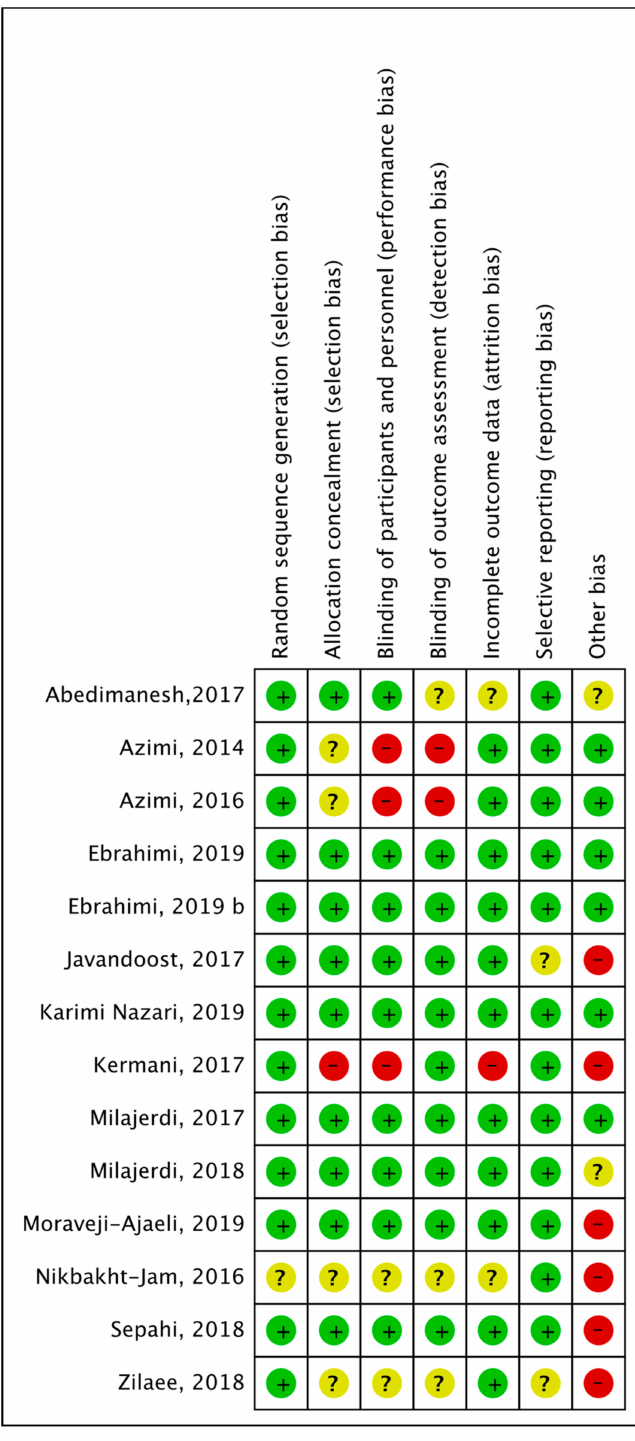
Figure 3. Risk of bias assessment summary for each included